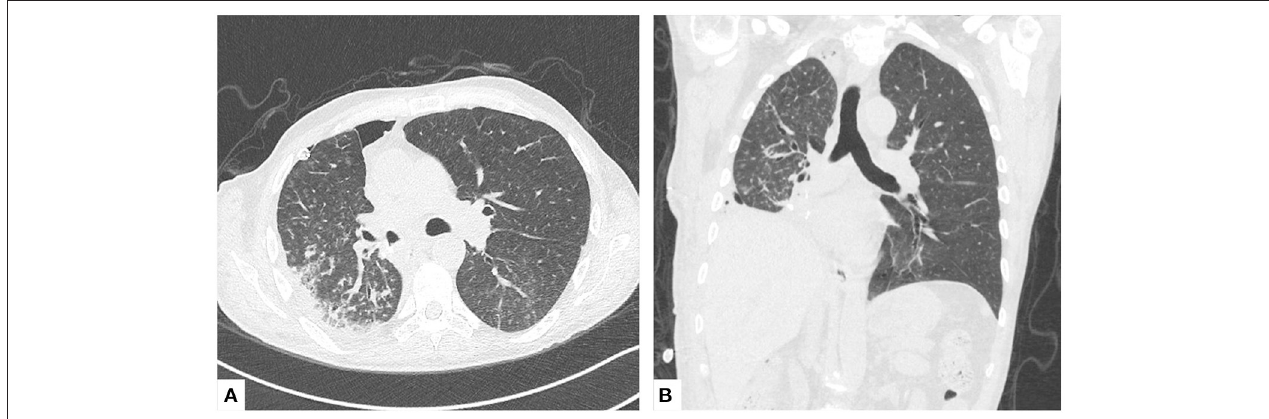
FIGURE 2 | Postoperative CT scan. (A) Axial and (B) coronal views of chest CT scans 1 month after the inferior